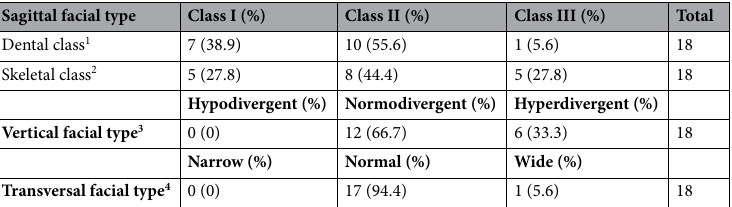
Table 1. Detailed sample characteristics. 1 Deviation less than ¼ of a molar cusp was considered Class I. 2 Class I: 1° ≤ ANB ≤ 6°, Class II: ANB > 6°, Class III: ANB < 1°. 3 Hypodivergent: MP-PP < 20°,